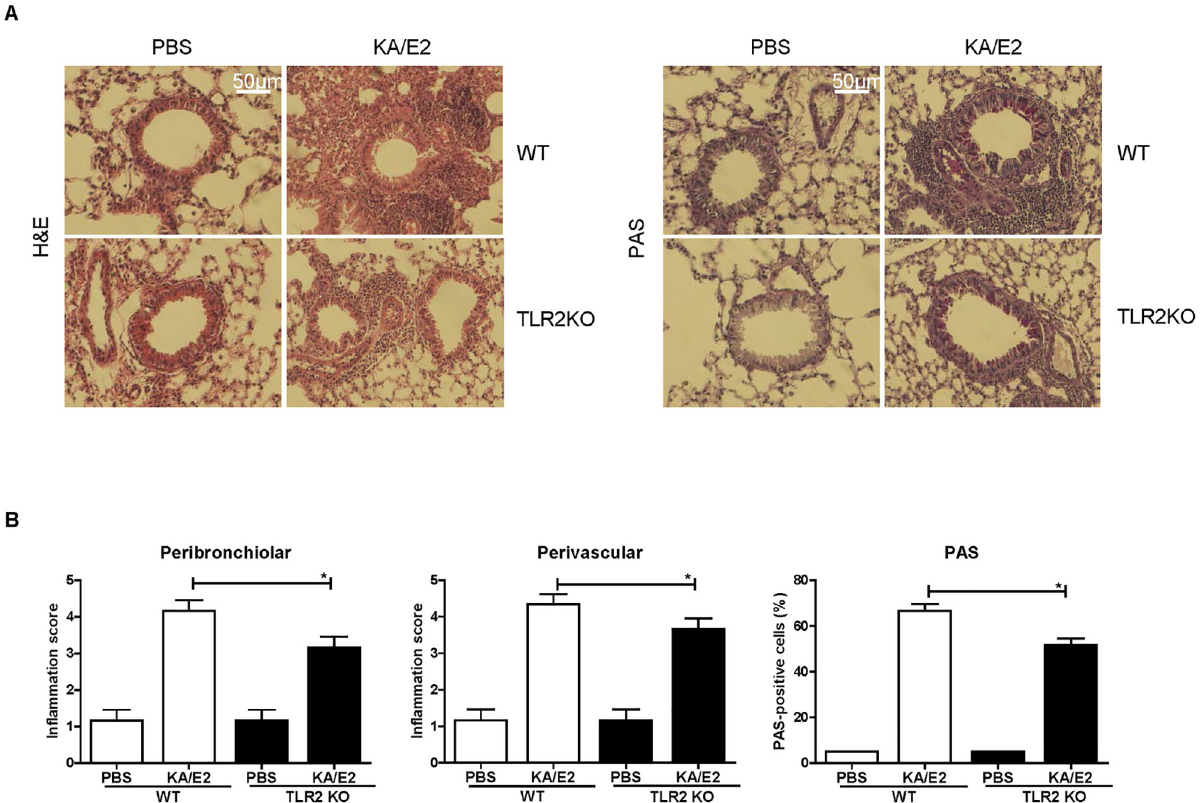
Fig 3. Comparison of the histopathological changes after KA/E2 treatment in WT and TLR2 KO mice. Tissue inflammation was observed in the images of lung sections after H&E or PAS staining (A). Representative inflammation scoring and PAS-positive cells (mean ± SEM). A grade of 0 indicates no detectable inflammation and a grade 4 indicates high percentages of airways and blood vessels in section cuffing by inflammatory cells (0 = normal tissue; 1 = < 25%; 2 = 25–50%; 3 = 51–75%; 4 = > 75%). Severity scoring was based on the thickness of the bronchi or vessels surrounding inflammatory cells (0 = no cells; 1 = 1–3; 2 = 4–6; 3 = 7–9 cells thick; 4 = 10 or more cells thick). Means of the p -value were calculated for comparison to the control (n = 5 mice/group, 3 independent experiments, � ; p < 0.05).